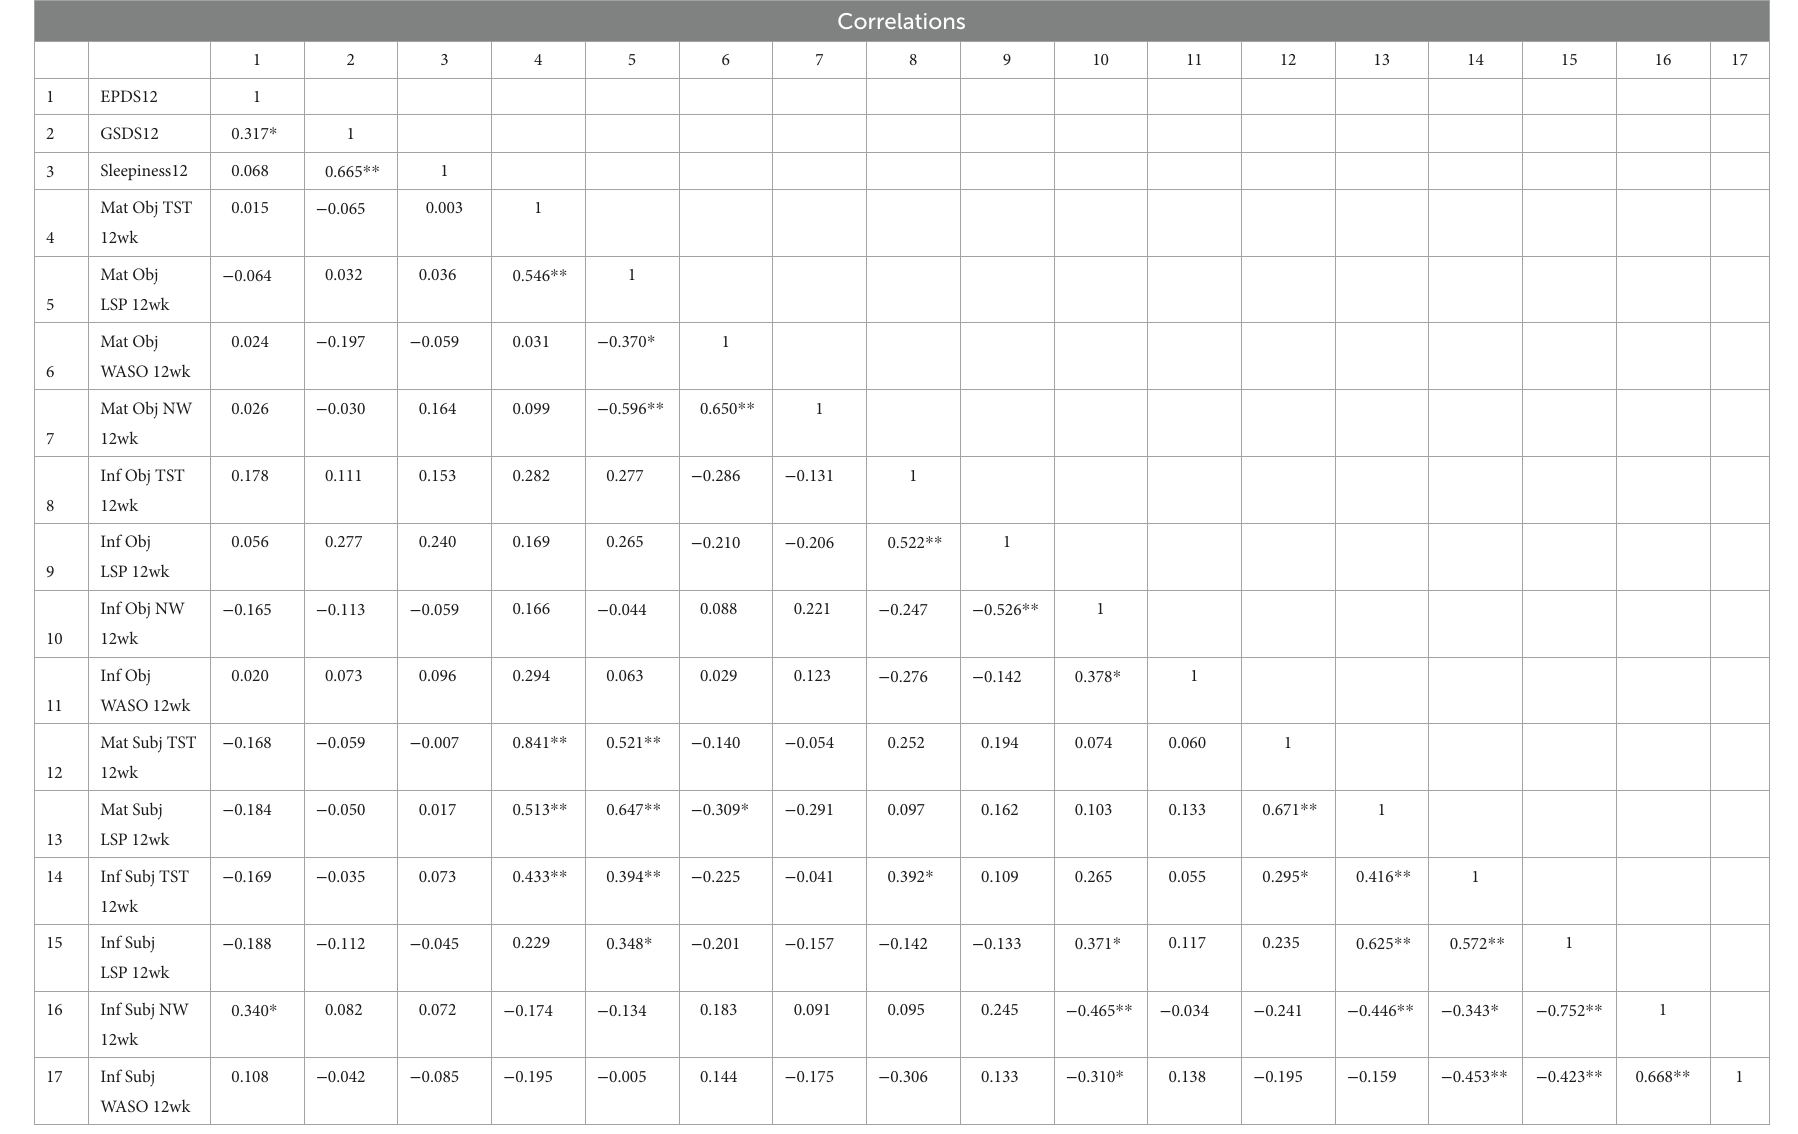
TABLE 4 Bivariate correlations between sleep measures, self-report measures, and EPDS at 12 weeks.